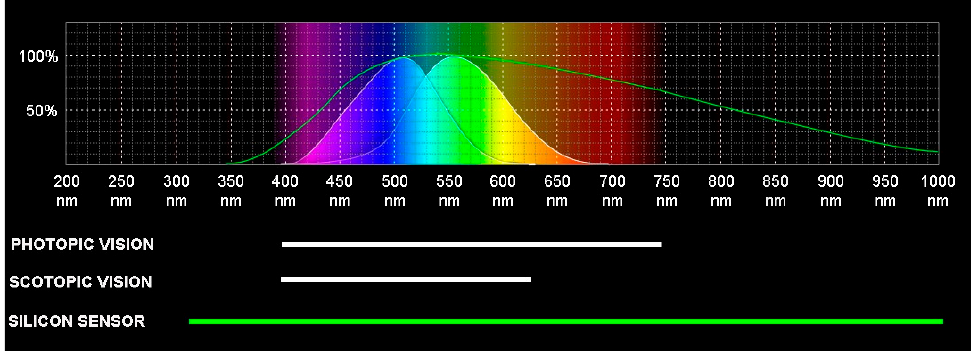
Figure 1. Normalized spectrum sensitivity for photopic and scotopic vision of the cones and rods of a human eye compared with a CMOS sensor.